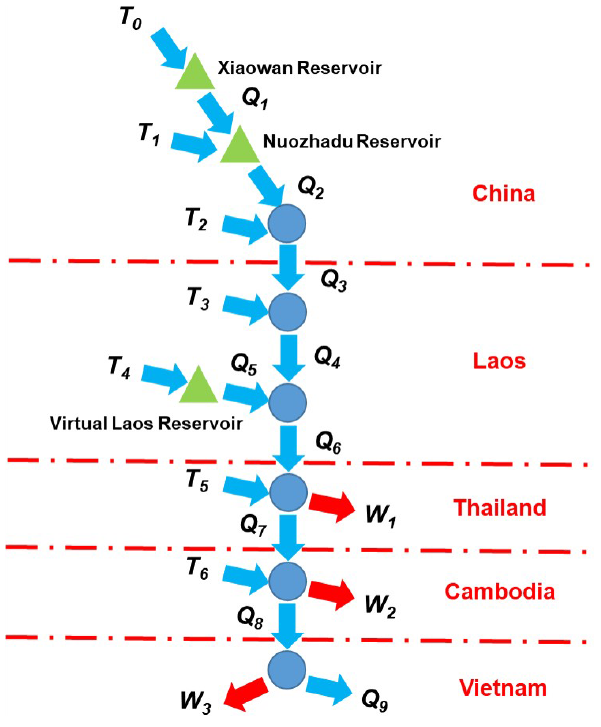
Figure 4. Framework of simplified water system in the Lancang– Mekong River